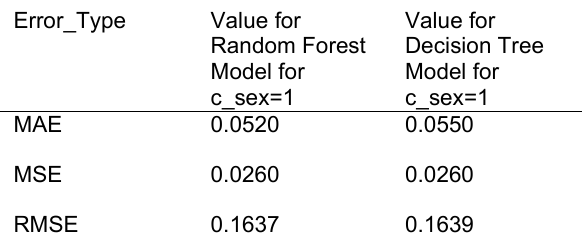
Table 3. Values of MAE, MSE, RMSE for overall